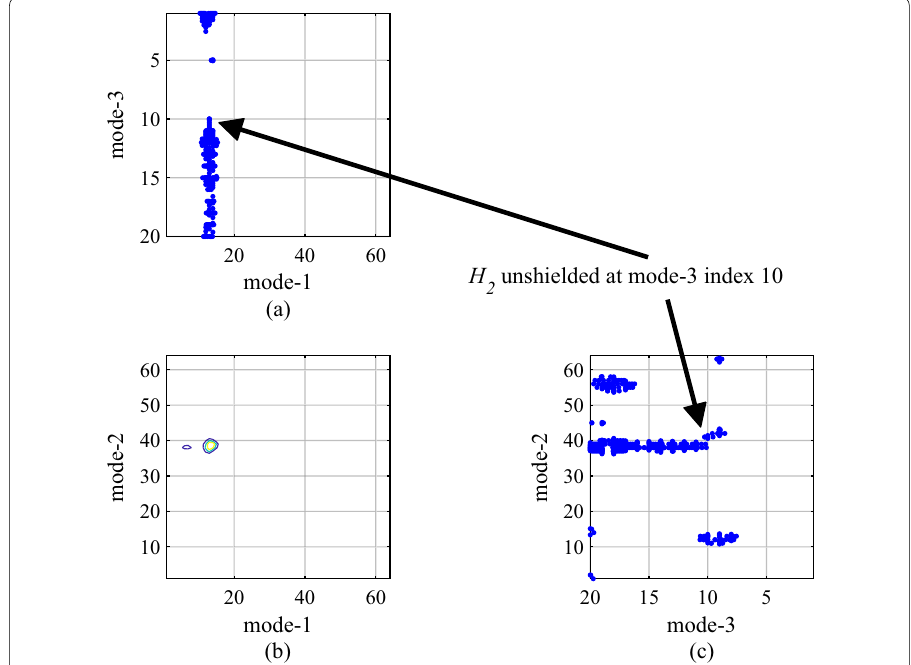
Fig. 8 Phase congruency in computed tensor M with unshielding of H 2 at frame 10 (mode-3 index 10). a , c Scatter plots along mode-3. b 3-level contour